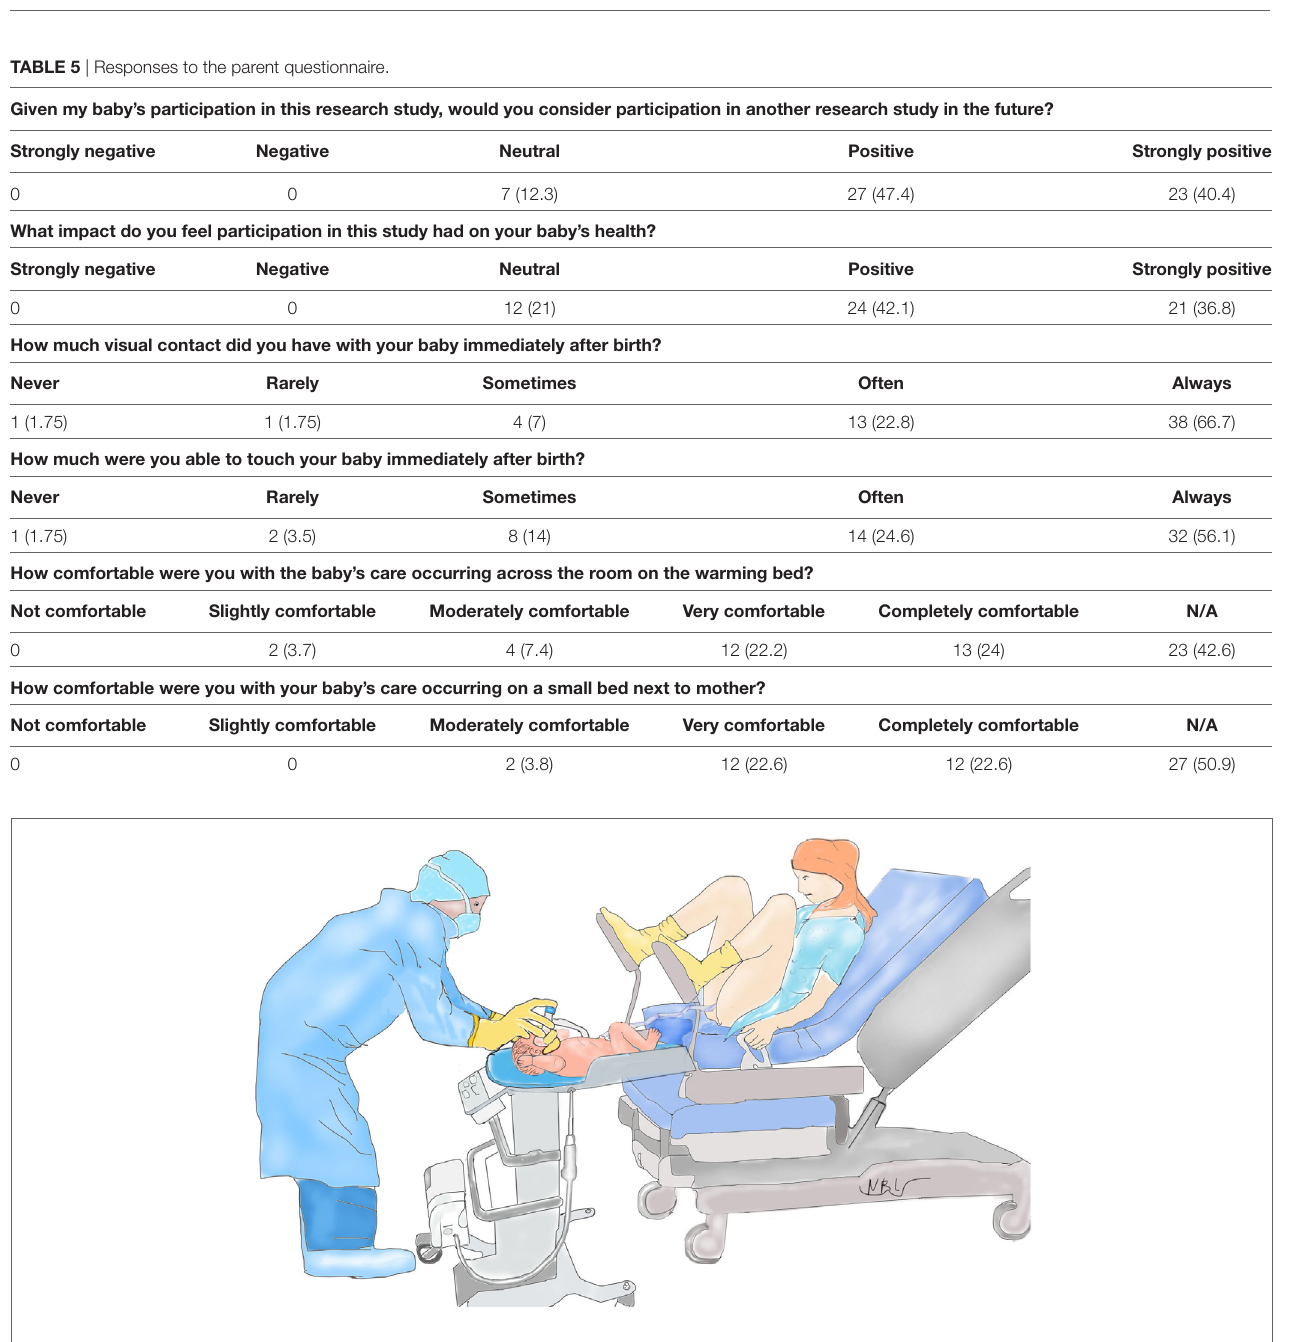
FigUre 1 | Setup for vaginal delivery in the United